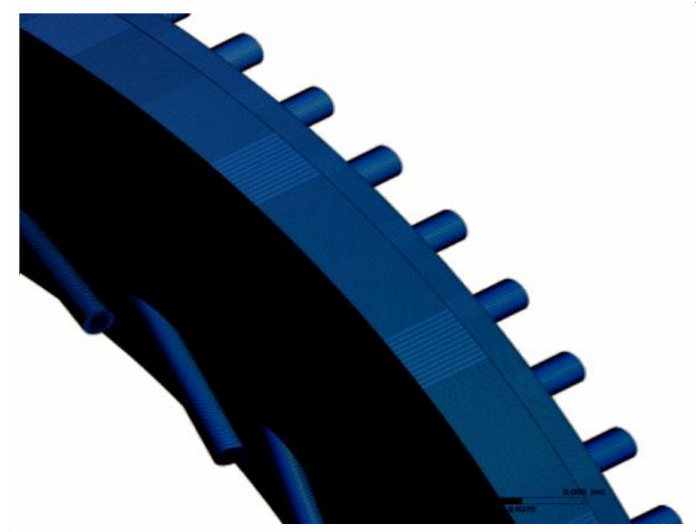
Figure 3. Local grid.